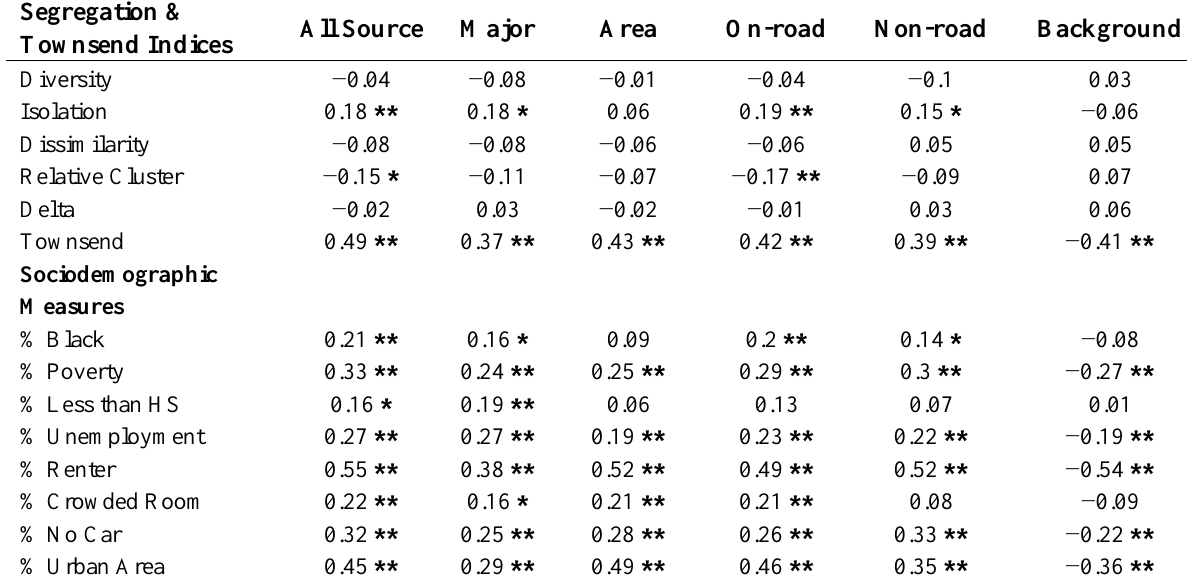
Table 2. Kendall’s tau between segregation indices, deprivation, sociodemographic measures and lifetime cancer risk from air toxics of different air pollution